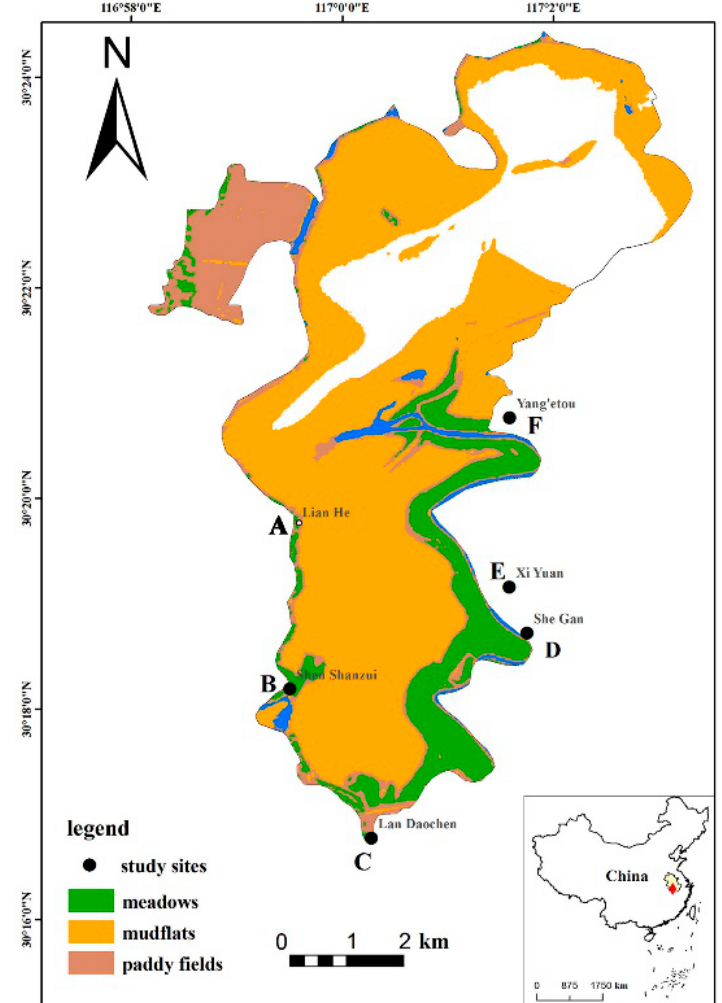
Figure 1. Foraging habitats for hooded cranes in the upper part of Shengjin Lake (A, B, C, D and E indicate the study sites).